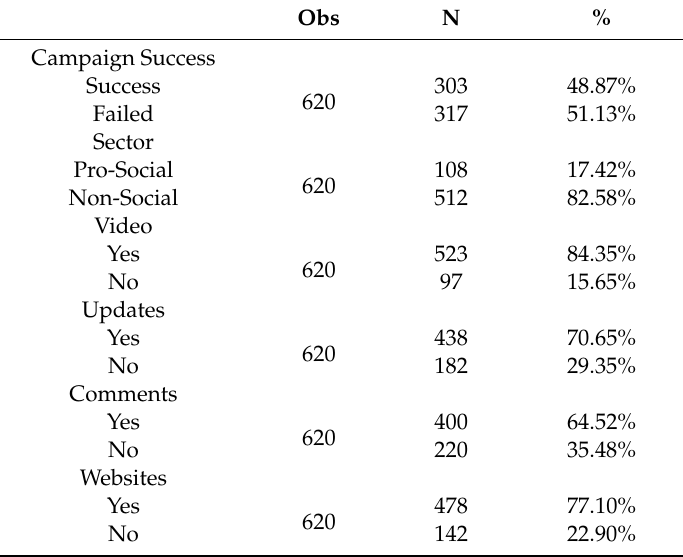
Table 3. Statistics of dummy